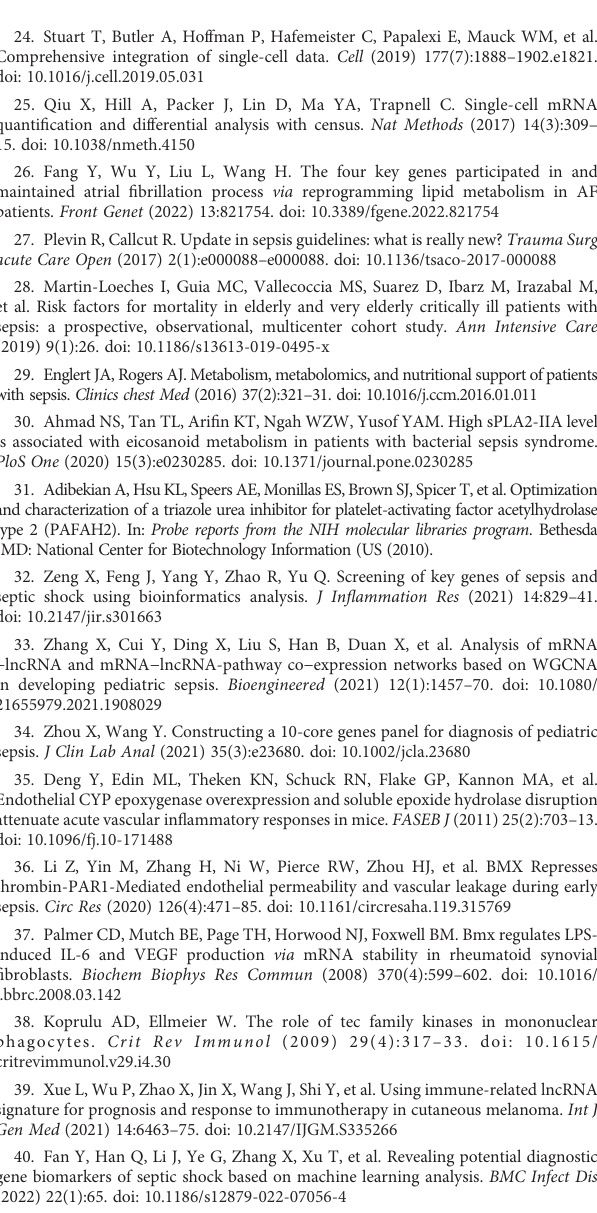
SUPPLEMENTARY FIGURE 2 (A) Subclusters and populations of Platelets. (B) Subclusters and populations of